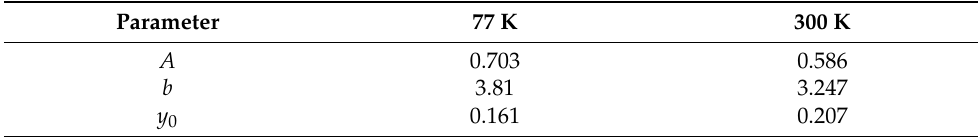
Table 2. Parameters of fitted exponential function as A exp ( − w / b ) + y 0 .